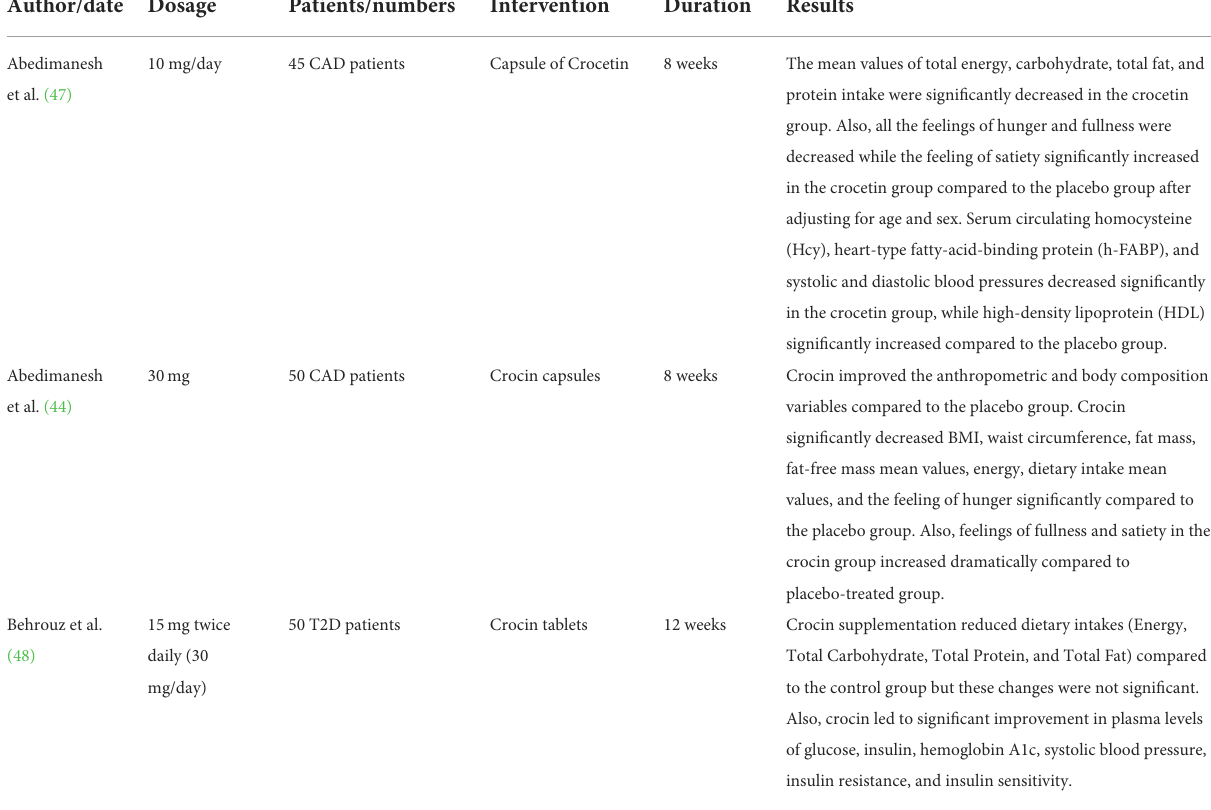
TABLE 3 Summary of effect estimates of saffron ingredients (crocin and crocetin) for dietary